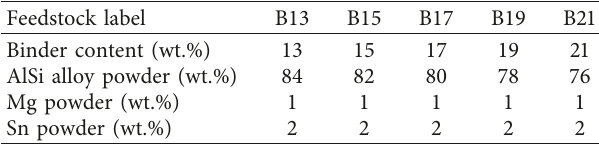
Table 2: Feedstock compositions used in this work. Feedstock